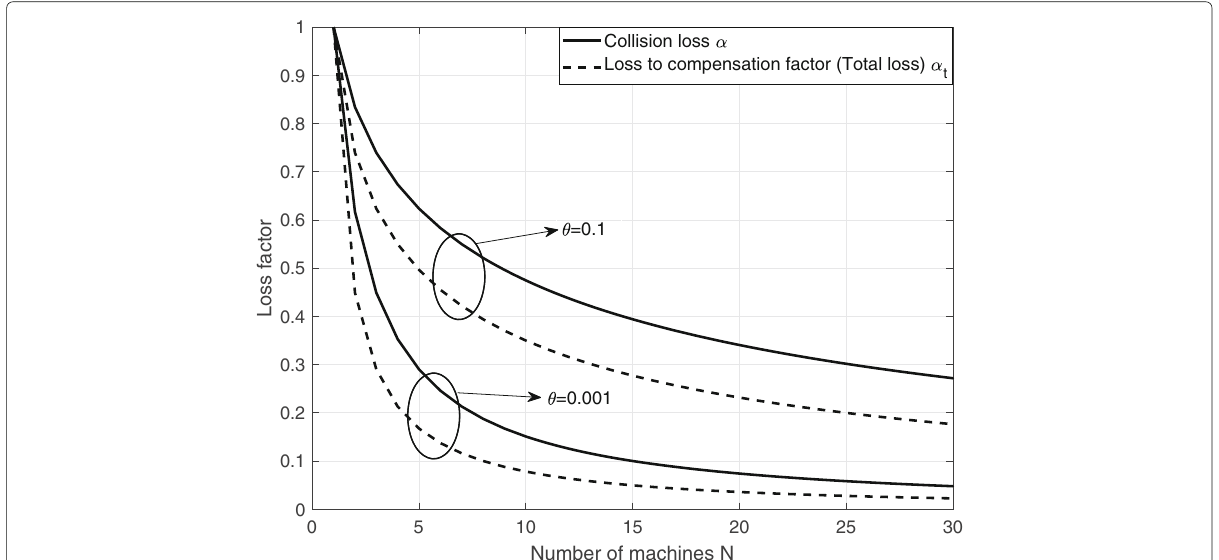
Fig. 6 Power-controlled loss factors. Loss factors α and α t vs number of nodes